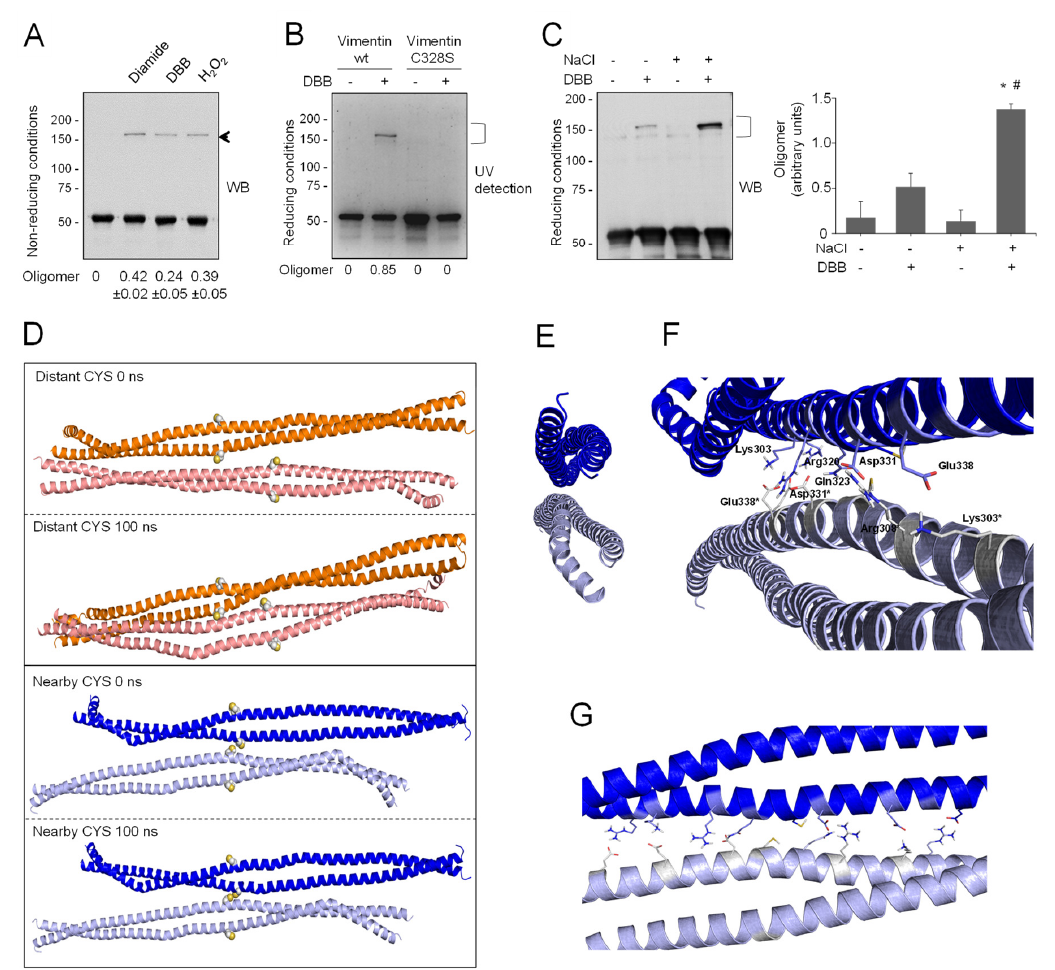
Figure 4. Cysteine-crosslinking of vimentin and potential conformations of the resulting dimers of dimers obtained by molecular dynamics. ( A ) Cysteine-crosslinking of vimentin (4.7 μ M final concentration) upon incubation with vehicle, 1 mM diamide, 24 μ M DBB, or 1 mM H 2 O 2 for 1 h at r.t. Incubation mixtures were analyzed by SDS-PAGE under non- reducing conditions and western blot. The position of the oligomer detected under these conditions is marked by an arrow. The oligomer/monomer ratios are displayed below the plot as average values ± SEM of three independent experiments. ( B ) Cys328 is required for DBB crosslinking. Vimentin wt or Cys328Ser (4.5 μ M final concentration) were incubated with 50 μ M DBB for 1 h at r.t, and subjected to SDS-PAGE, followed by Sypro Ruby staining for detection of vimentin mono- meric and oligomeric (marked by a bracket) species under UV light. Cysteine-crosslinked oligomeric species were esti- mated by image scanning, and values are presented below the plot in arbitrary units. ( C ) Effect of NaCl-induced polymer- ization on DBB vimentin crosslinking. Vimentin wt (3.8 μ M final concentration) was incubated with vehicle or 150 mM NaCl for 10 min at 37 °C (conditions that induce polymerization) and subsequently incubated for 1 h at r.t. with vehicle or 24 μ M DBB. Samples were analyzed by SDS-PAGE and western blot, and representative results are presented. The proportion of oligomeric (bracket) versus monomeric species is shown in the graph on the right. Results are average values of three assays ± SEM. * p < 0.05 vs. control (-NaCl, -DBB); # p < 0.05 vs. (-NaCl, +DBB) by paired Student’s t -test. ( D ) Models of vimentin dimers of dimers. Distant-CYS and nearby-CYS tetramers are represented in orange and blue, respec- tively. For each dimer, 100 ns of MD simulation were performed. The structures of the initial and last frames of the simu- lation are shown. Cys328 is represented in spheres. ( E ) Front view of the dimerization interface between both vimentin dimers in the nearby-CYS tetramer. ( F,G ) Semi-lateral ( F ) and lateral ( G ) views of both vimentin dimers in the nearby- CYS tetrameric association with details of the interactions that take place at the dimerization interface. Interacting residues are depicted as sticks.